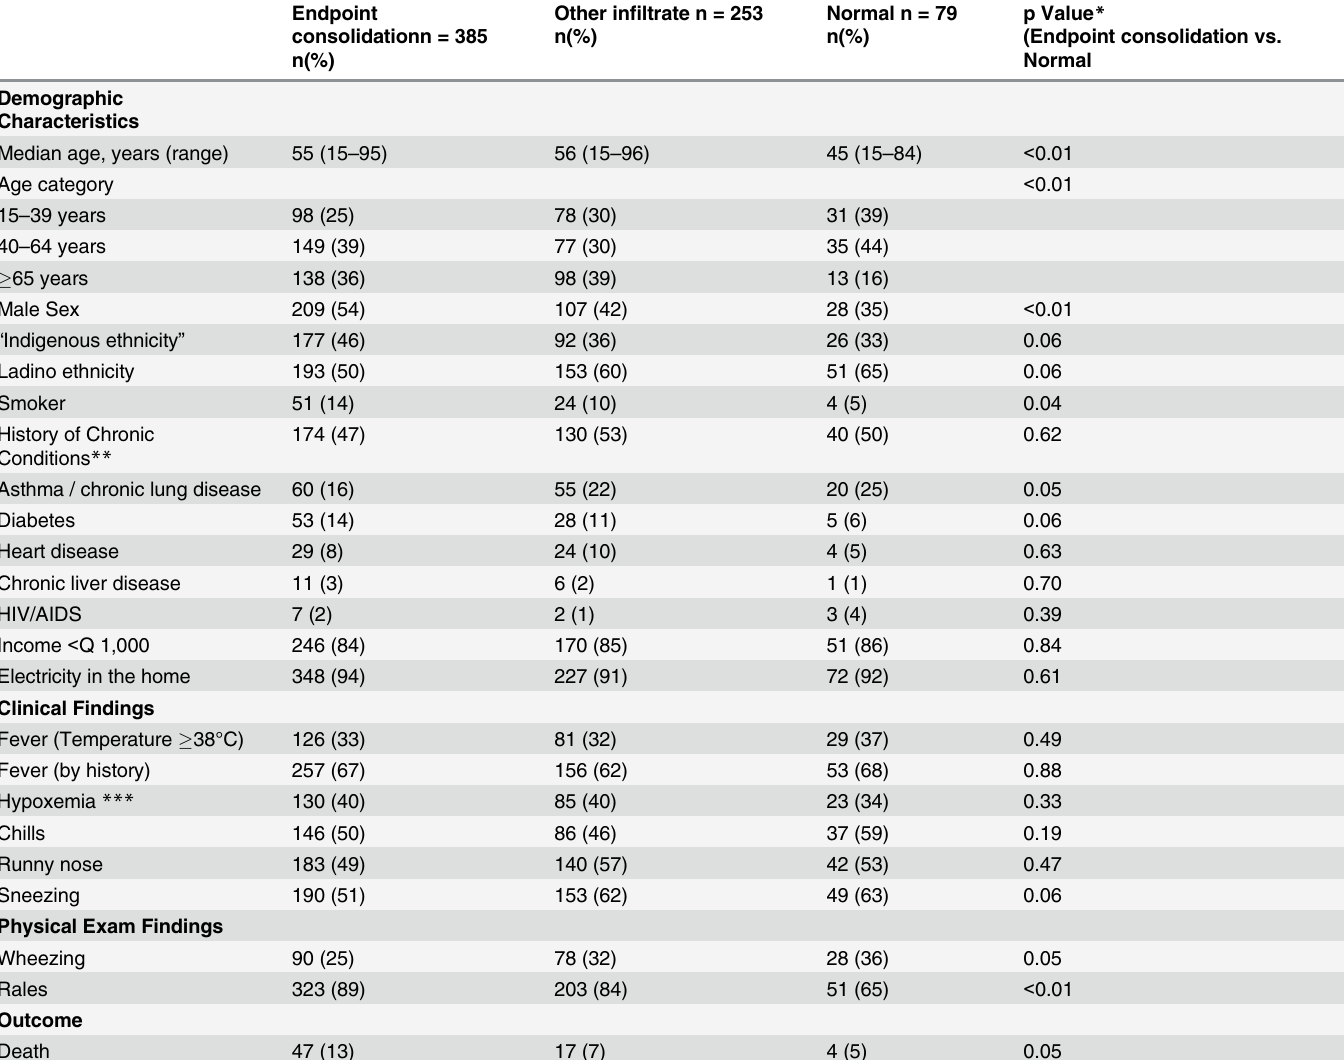
Table 2. Patient Demographic and Clinical Characteristics by WHO CXR